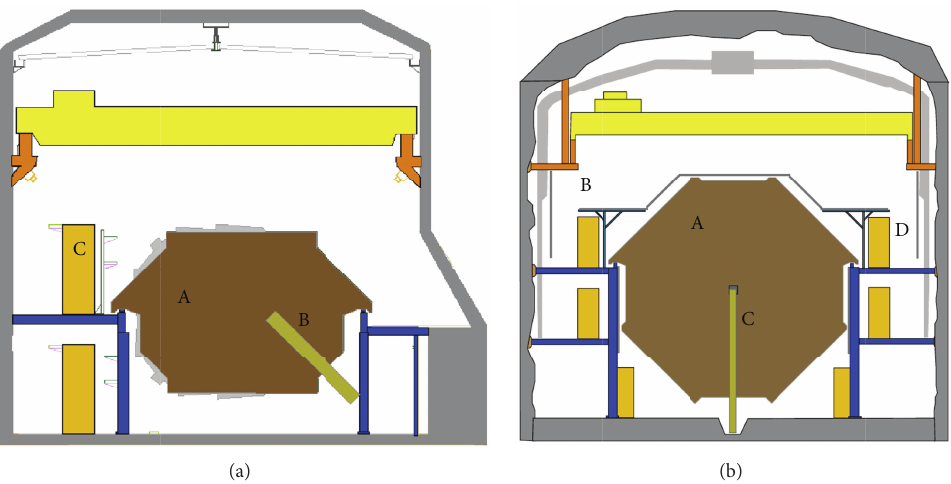
Figure 9: Schematics showing the end views of the MINOS Near (a) and Far (b) detectors. For the Near detector the label “A” identifies the upstream steel plate, “B” is the magnet coil, and “C” is an electronic rack. For the Far detector, “A” identifies the steel plane at the end of the second supermodule, the furthest downstream in the beam, “B” is the cosmic ray veto shield, “C” is a magnet coil, and “D” is an electronics rack. The detectors are shown with different scales: the Near detector is 3m wide compared to 8 m for the Far detector. Figure from